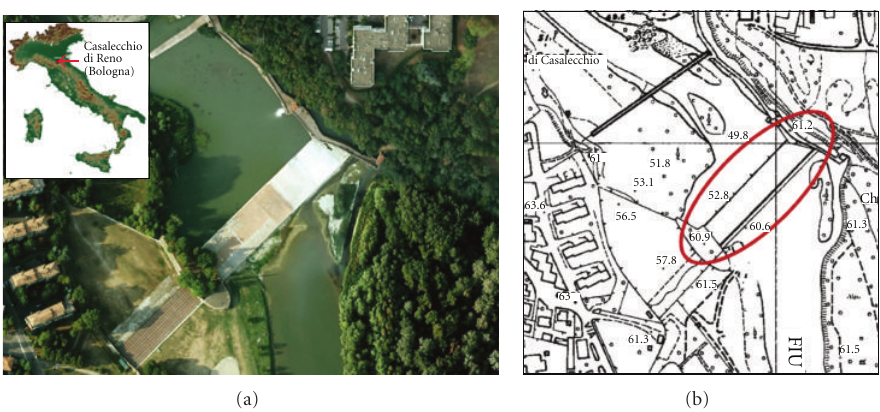
Figure 1: The Casalecchio di Reno sluice on high-resolution satellite image and 1:5000 technical map.